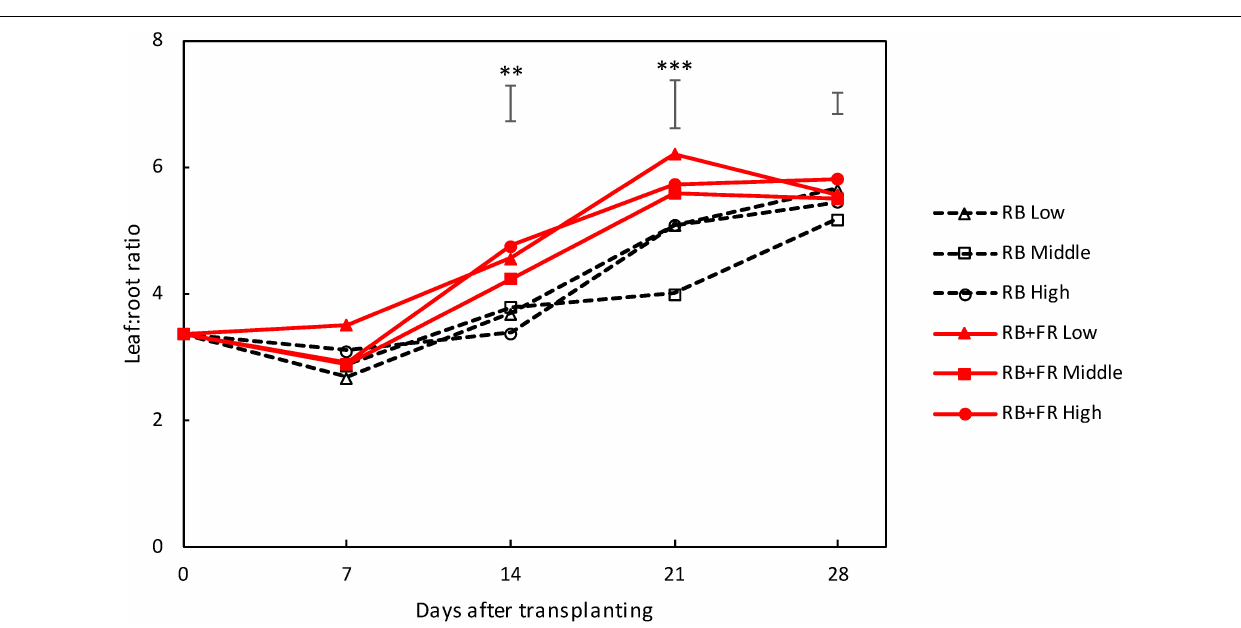
FIGURE 4 | Pattern of leaf/root ratio over time for lettuce plants grown with or without far-red radiation (FR) at three planting densities (low, middle, and high being 23, 37, and 51 plants m − 2 , respectively). Solid lines represent RB + FR treatment and dashed lines indicate RB treatment. Bars on top of each day represent least significant difference. Significant FR effect: ∗∗ P < 0.05 and ∗∗∗ P < 0.01. Data are means of two ( n = 2) or three blocks ( n = 3) each with four–six replicate